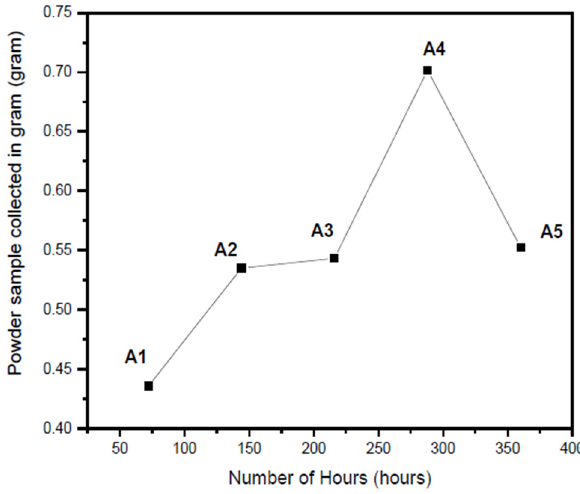
Figure 2. Yield of collected samples A1, A2, A3, A4, and A5 against the number of